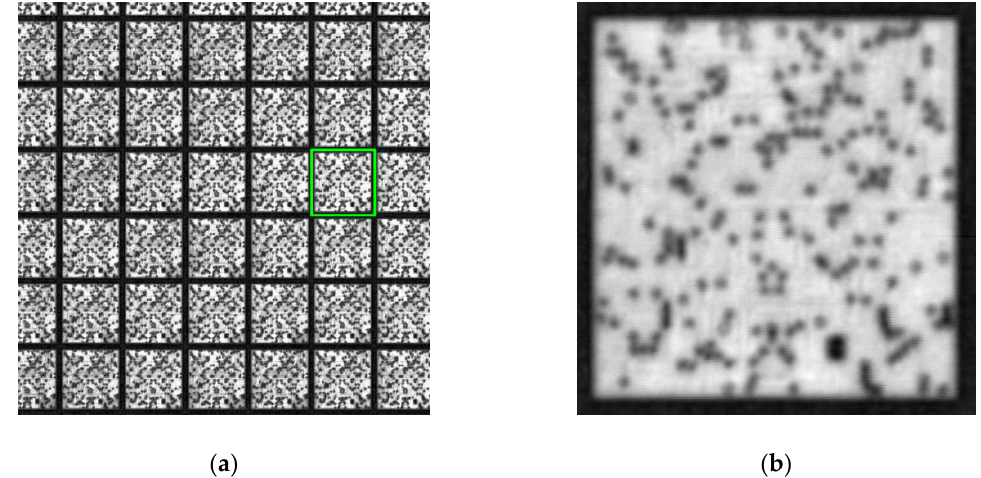
Figure 6. Binarized image of the initial template in Figure 3.